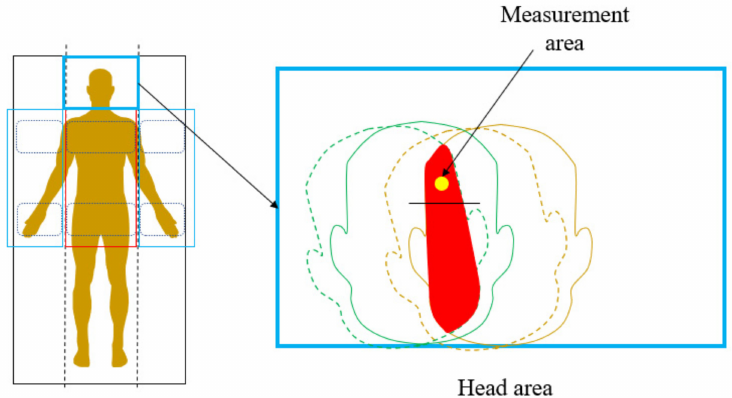
Figure 11. Schematic diagram of temperature sensor measurement